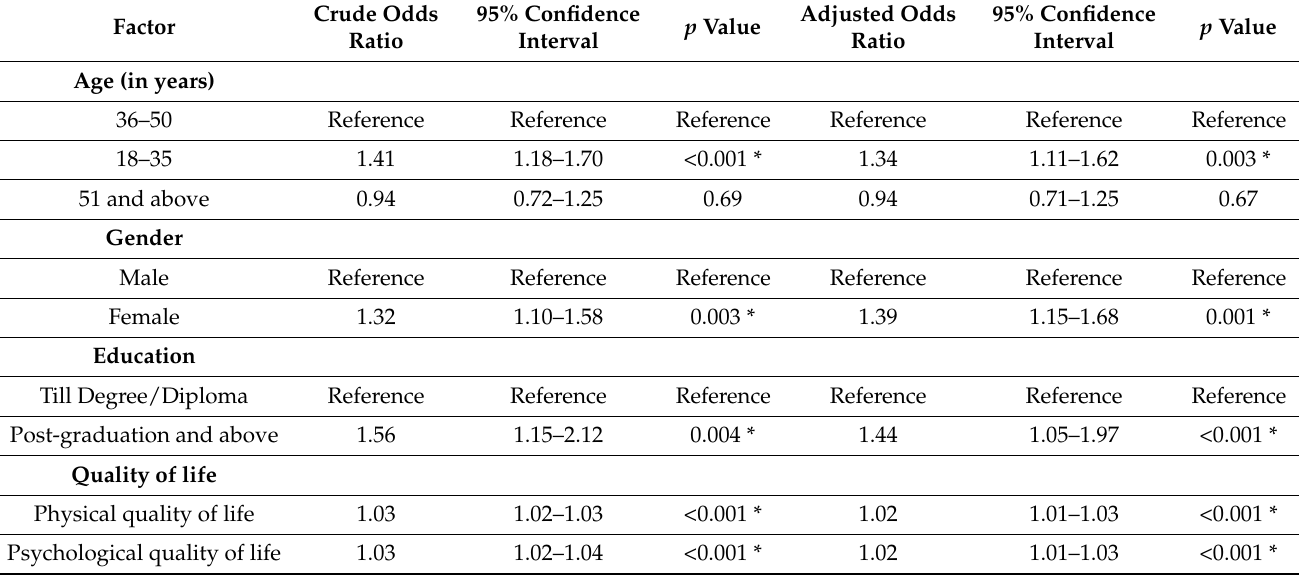
Table 6. Factors associated with increase in life skills among participants (multiple logistic